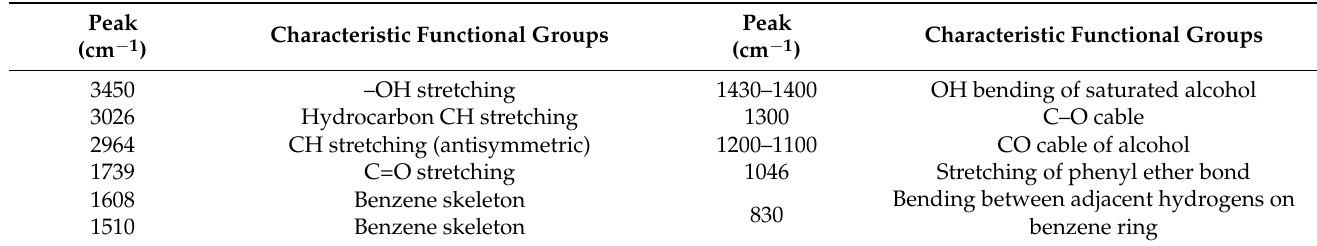
Figure 6. FTIR of epoxy resin specimens immersed in distiller water or the alkali solution for 150 days of ( a ) Overall infrared spectrum and ( b ) local infrared spectrum of groups below 1800 cm − 1 . Table 2. Characteristic groups corresponding to each peak of the infrared spectrum of epoxy resin after immersion [29].